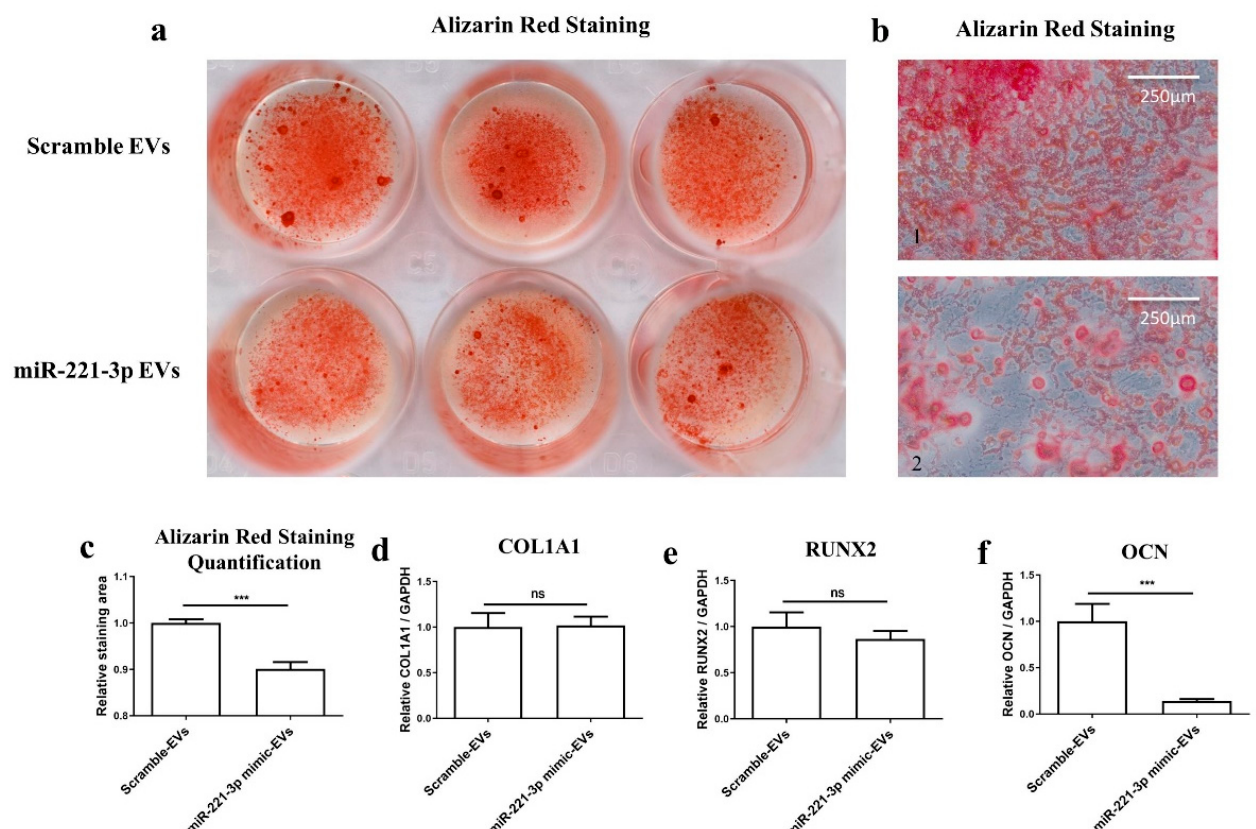
Figure 8. Osteoblasts were treated with EVs isolated from chondrocytes supernatant with or without miR-221-3p overexpression for 2 weeks in ODM. The microscopic ( a ) and macroscopic ( b ) result of Alizarin Red staining, respectively. Quantitative analysis of the Alizarin Red staining area through ImageJ ( c ), threshold = 120. The relative expression level of osteogenic markers ( d – f ), COL1A1, RUNX2, and OCN in the two groups. Relative to GAPDH. ns stands for not statistically significant, *** p < 0.001 vs. corresponding control. ODM = Osteogenic differentiation medium.